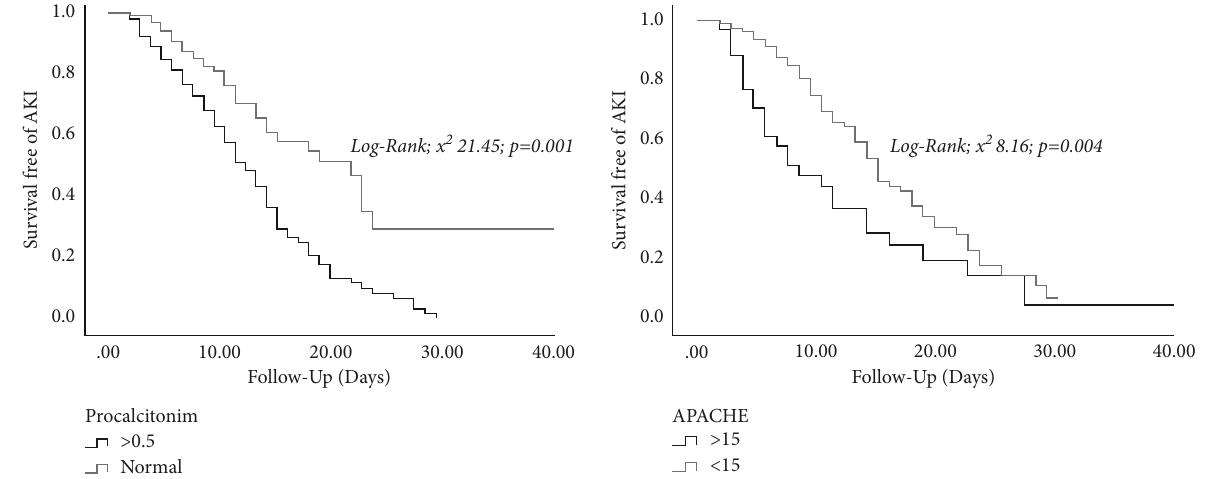
Figure 2: Acute kidney injury-free time according to procalcitonin and APACHE